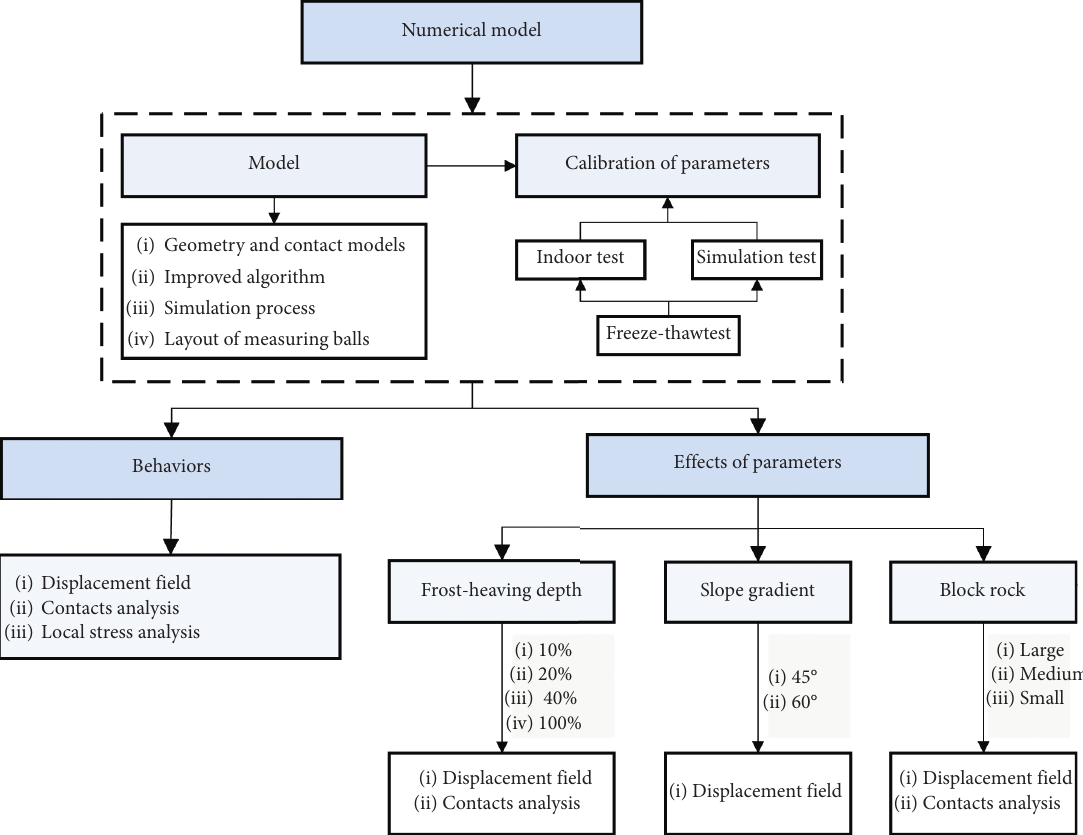
Figure 2: Experimental design.